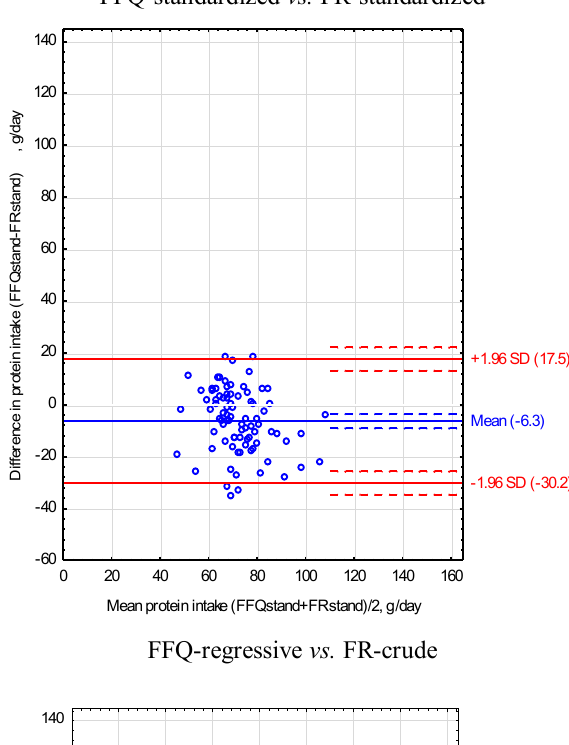
FFQ-adjusted vs. FR-crude FFQ-regressive vs.